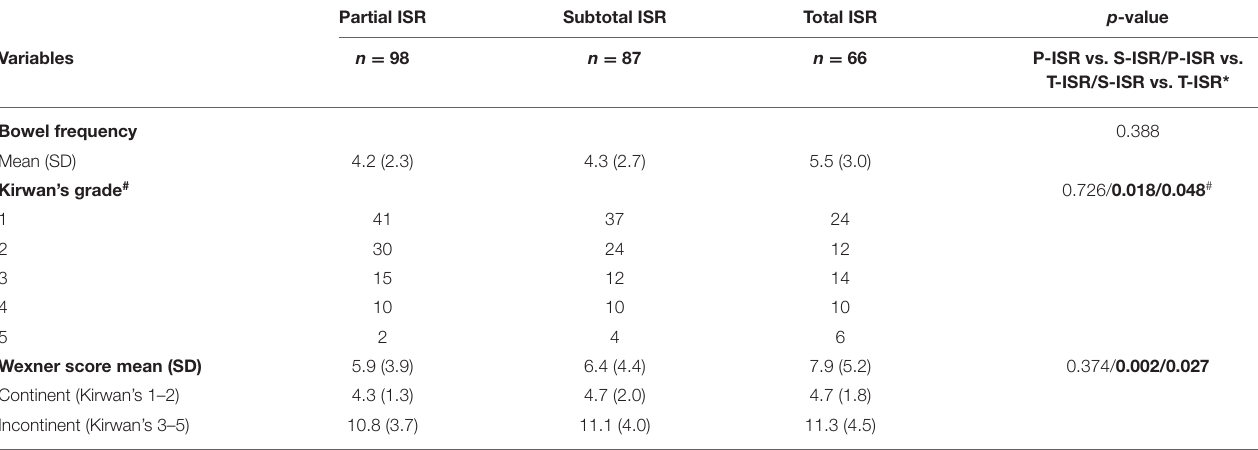
TABLE 4 | The anorectal function was evaluated 3 months after stoma closure. Partial ISR Subtotal ISR Total ISR p -value Variables n = 98 n = 87 n = 66 P-ISR vs. S-ISR/P-ISR vs. T-ISR/S-ISR vs.